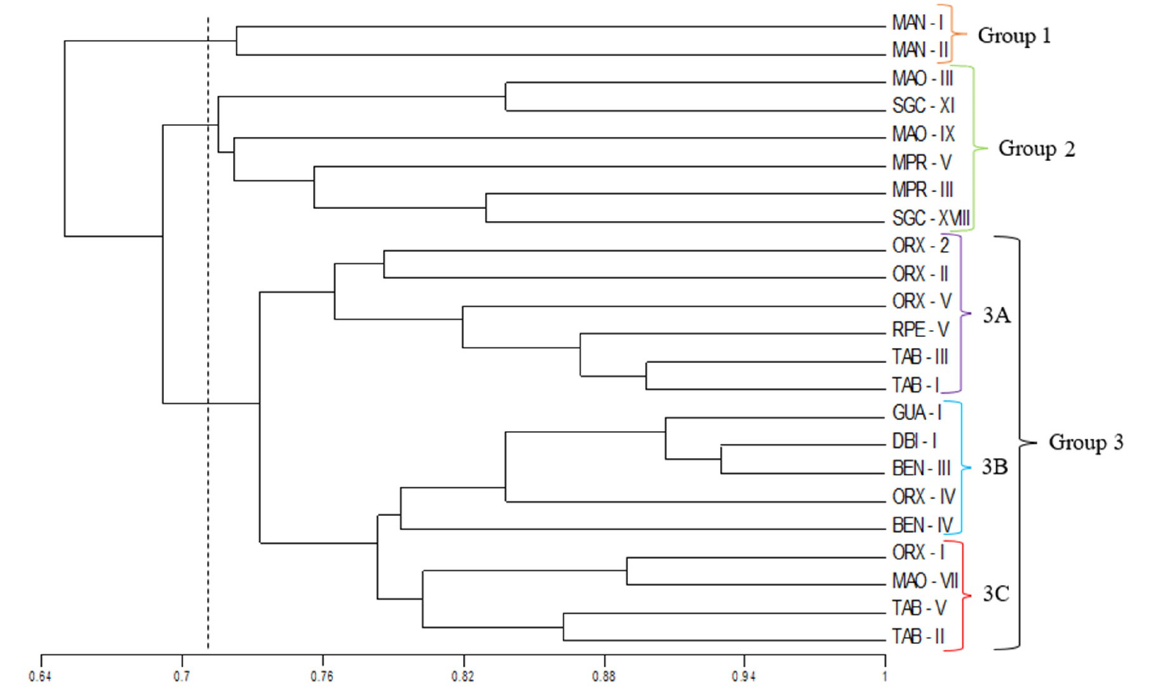
Figure 2. Hierarchical clustering by the UPGMA method and Gower general similarity coefficient of 23 C. chinense genotypes, evaluated by 21 morphological descriptors. Cophenetic correlation = 0.6623. The dashed vertical line represents the estimated cut by the Mojema method.